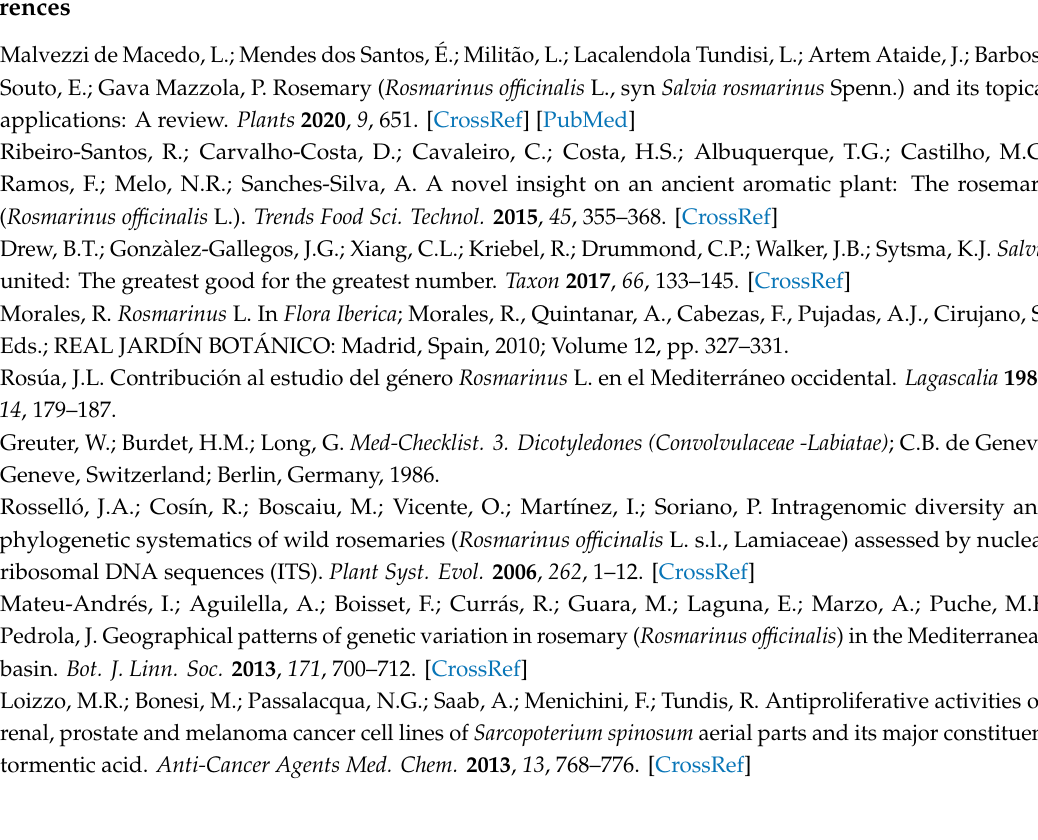
Figure S1: Chromatogram of S. rosmarinus essential oil from Ionian coast (sample R1), Figure S2: Chromatogram of S. rosmarinus essential oil from Tyrrhenian coast (sample R2), Figure S3: Mass spectra of the most representative constituents of rosemary essential